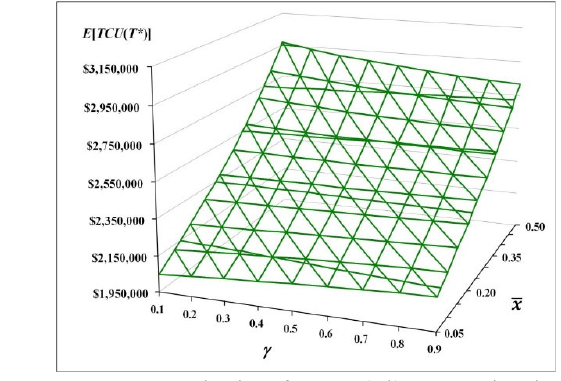
Fig. 12. Impact of both the nonlinear and linear relationships between δ and γ on E [ TCU ( T *)]